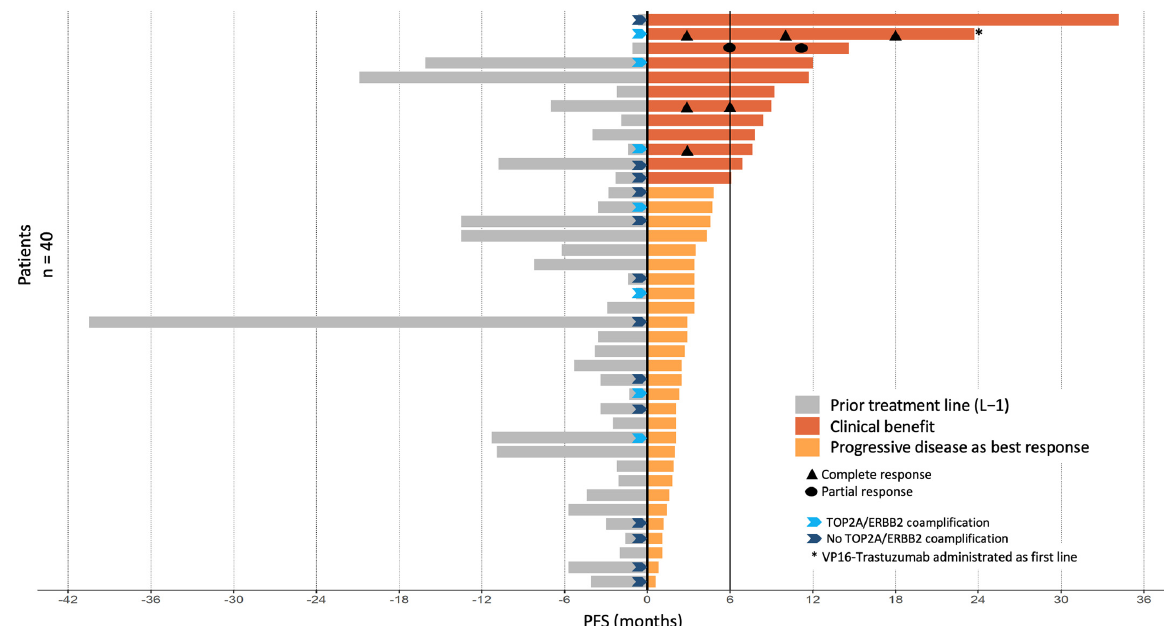
Figure 2. PFS by patient in relation to prior treatment lines and VP16 ‐ T. Clinical benefit was defined by either an objective tumor response ( n = 4 patients) and/or a PFS under VP16 ‐ T for longer than 6 months ( n = 8 patients).